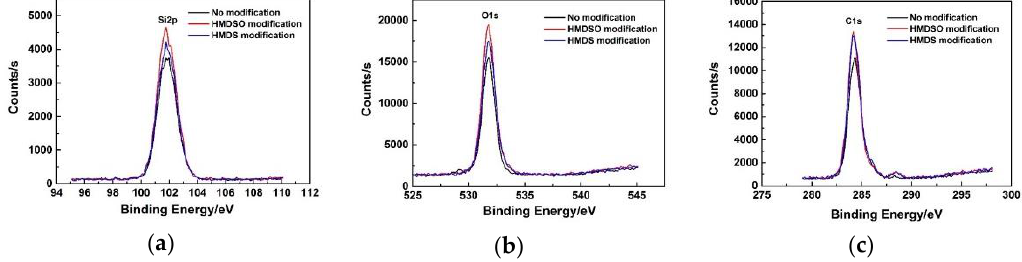
Figure 6. ( a ) Si2p, ( b ) O1sand ( c ) C1s XPS spectra of flexible MSQ aerogels without or with surface modifications.